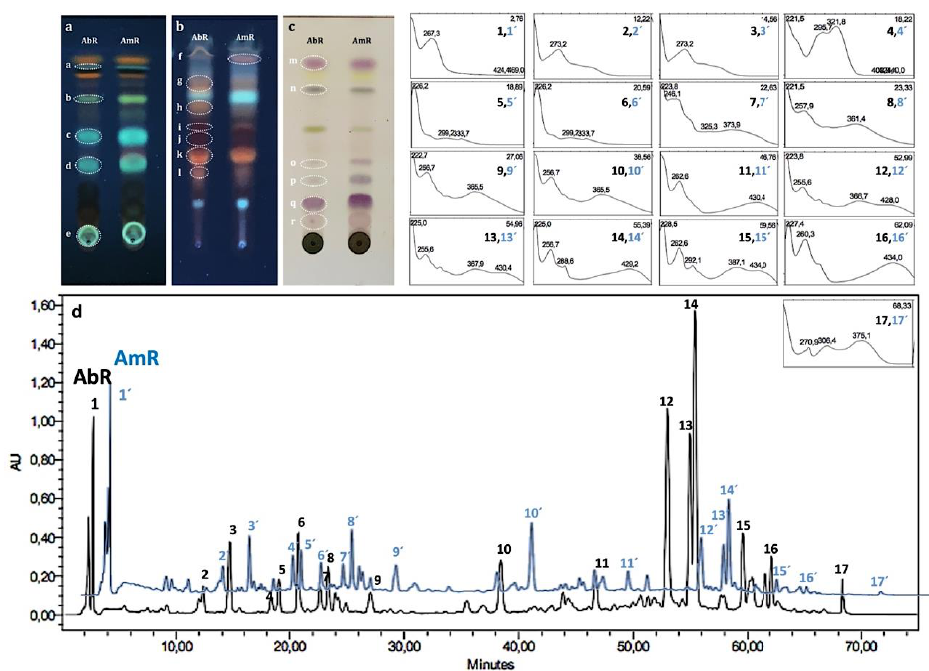
Figure 3. TLC and HPLC-UV/DAD chromatographic profiles of secondary metabolites of A. bento- rainhae and A. macrocarpus root tuber extracts. Phenolic acid derivatives detection, SiG60, spraying with NP/PEG, solvent system: S1, UV:366 nm ( a ); anthracene derivatives detection, SiG60 RP 18 , spraying with KOH 5%, solvent system: S2, UV:366 nm ( b ); terpenoids detection, SiG60 spraying with anisaldehyde-sulphuric acid, solvent system: S3, visible light ( c ); comparative chromatograms of AbR and AmR extracts ( d ). Table 2. Quantification of principal chemical classes of A. bento-rainhae and A. macrocarpus root tuber